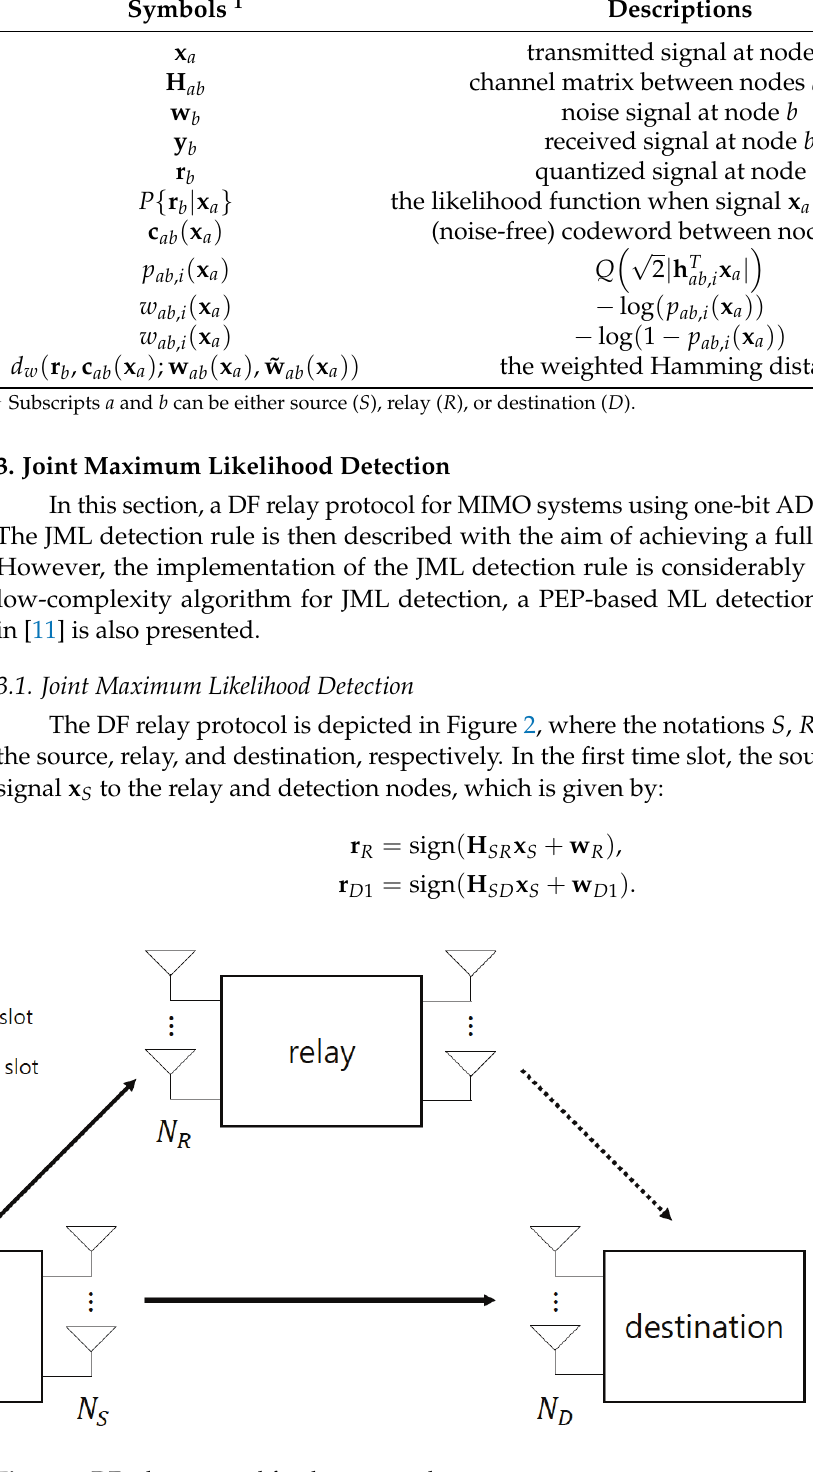
Figure 2. DF relay protocol for the proposed